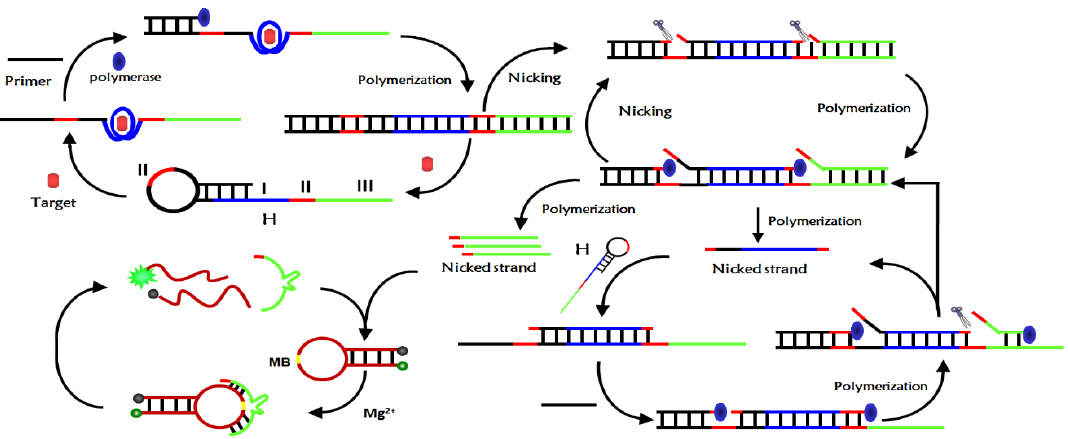
Figure 1. Detection principle of fluorescent aptamer sensor based on isothermal exponential amplification reaction and deoxyribonuclease signal amplification.